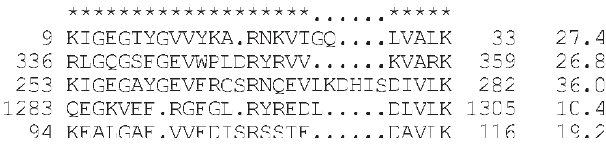
Figure 1. A typical motif alignment from GLAM 2. The stars indicate the key positions. The residues inserted between key positions are not considered aligned to each other: their column placement is arbitrary. The numbers on either side of the aligned segments indicate the coordinates of each segment within the sequence. The decimal numbers on the right are the marginal scores of each aligned